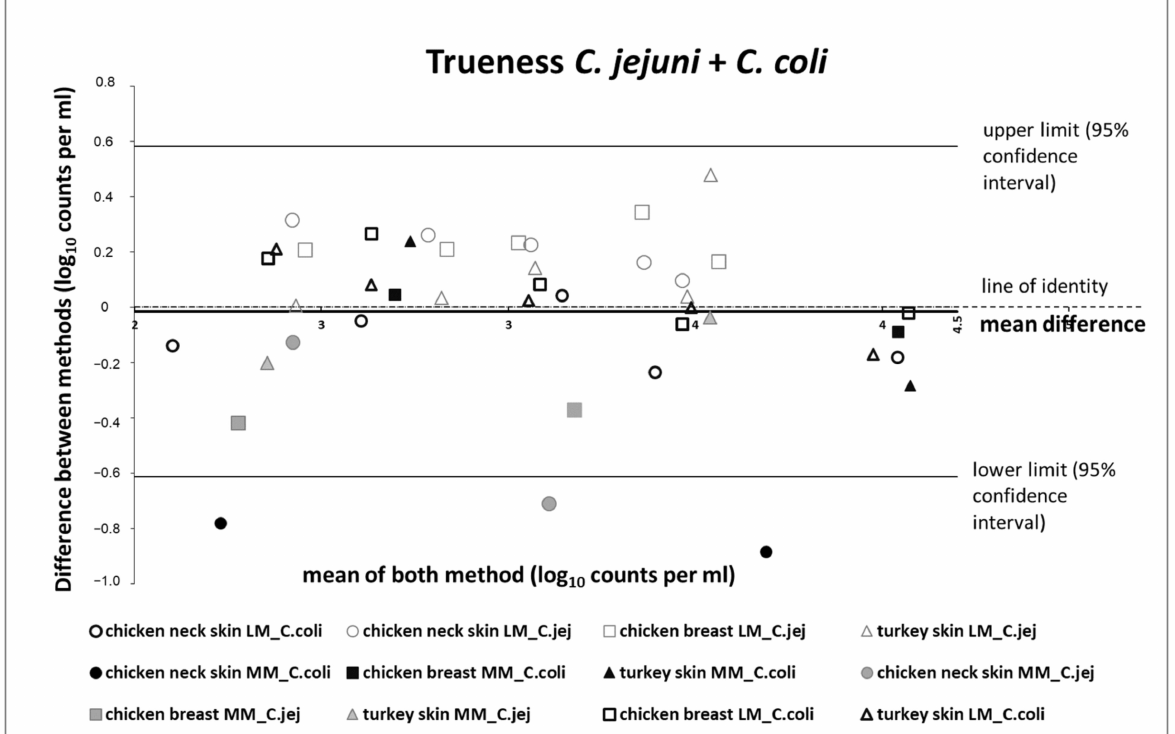
Figure 3. Bland–Altman difference plot for three different types of raw meat ( C. jejuni and C. coli , low and medium organic matrix). LM: Low organic Matrix; MM: Medium organic Matrix, grey measurement points for C. jejuni , black measurement points for C. coli